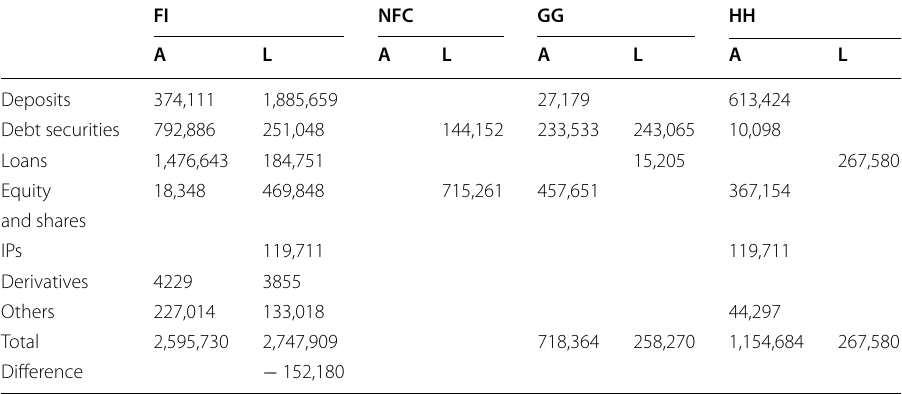
Source: created by authors using IIP published by SAFE, Almanac of China’s Finance and Banking 2016 and China Financial Bulletin 2016. A: assets; L: liabilities Table 10 Estimation of China’s HH, FI and GG Sectors and debt securities (in units of 100 million